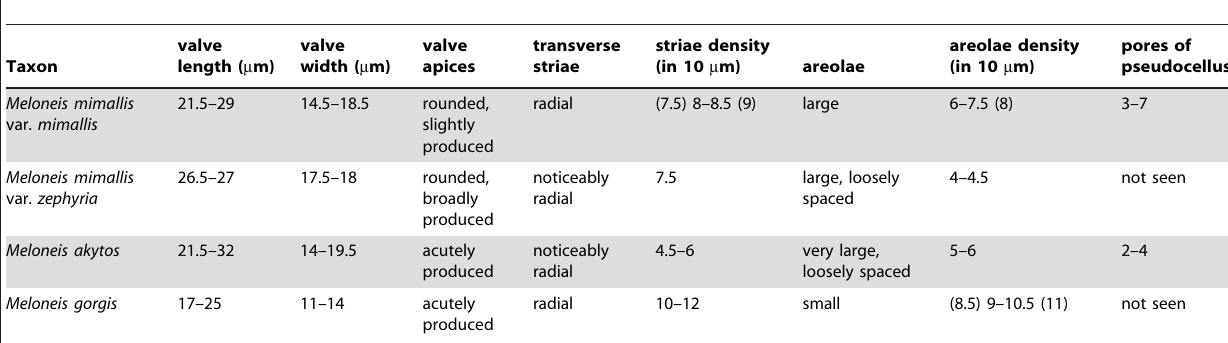
Table 2. Characters of valve morphology differentiating the four taxa of Meloneis